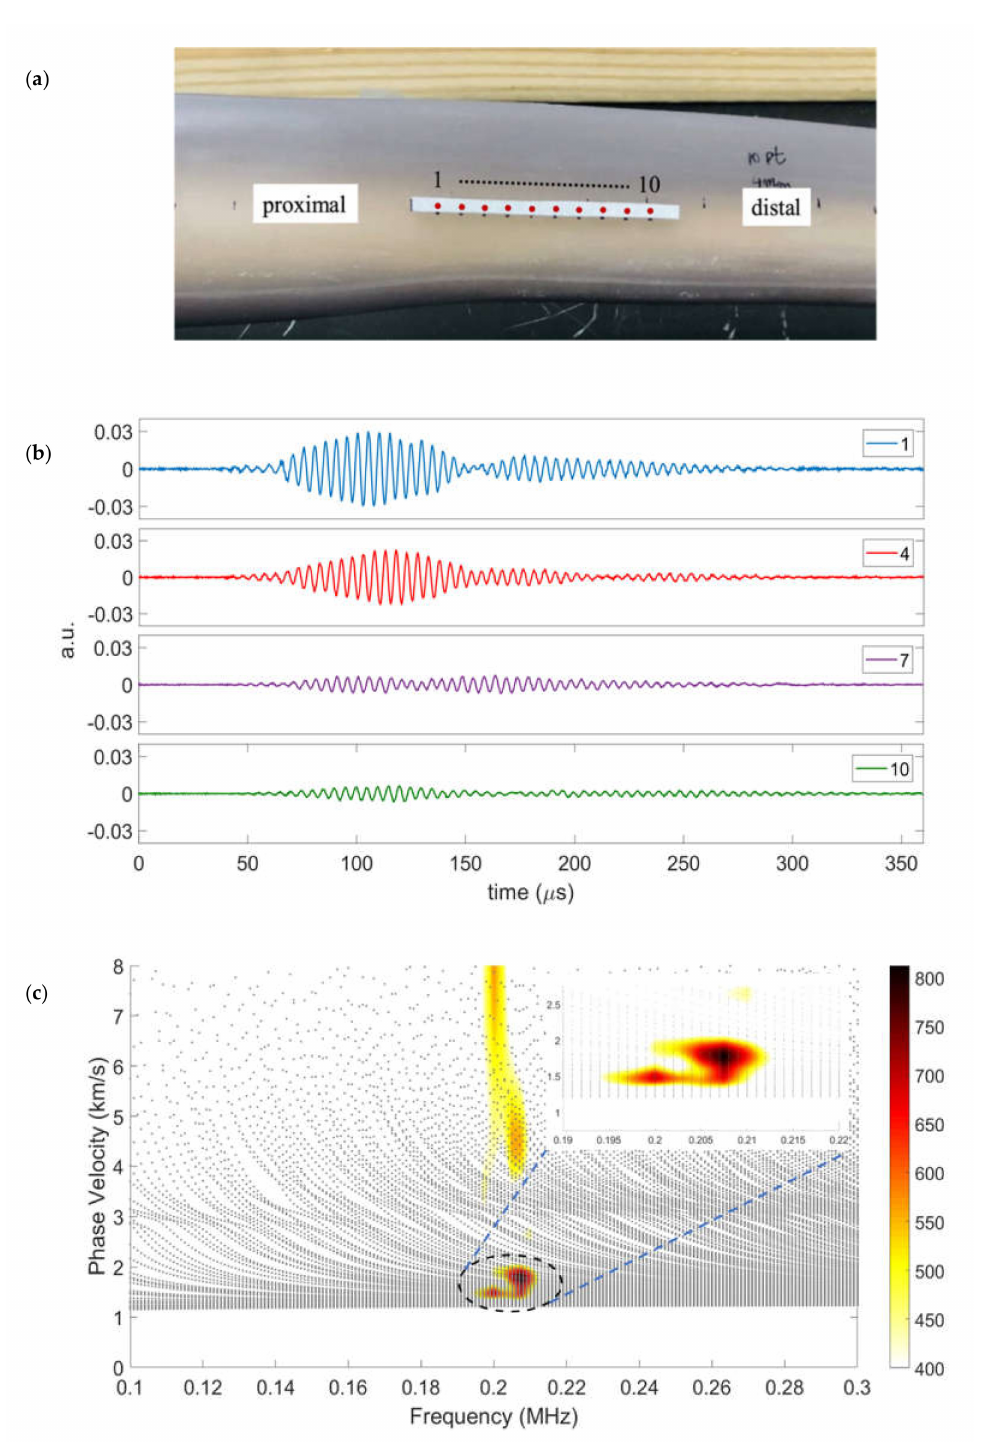
Figure 4. LDV results measured on a synthetic tibia: ( a ) measurement points on the reflective tape; ( b ) A-scans recorded at points 1, 4, 7, and 10; ( c ) phase velocity spectrum obtained from 2D-FFT of data recorded at 10 points overlaid on dispersion curves obtained from finite element